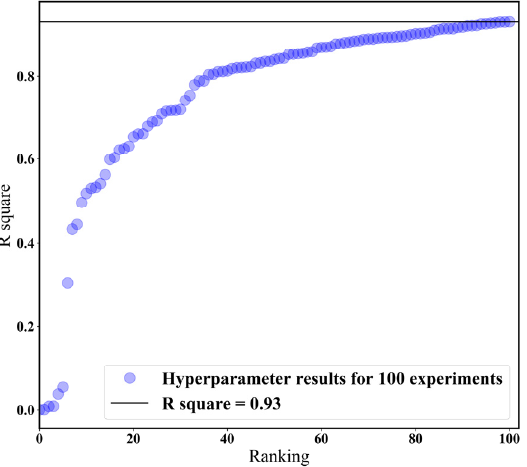
Figure 5. Results of hyper-parameter optimization. The experiments were carried out according to 100 experiments. The experiments have different combinations of neural network parameters such as epoch, learning rate and number of layers, etc.